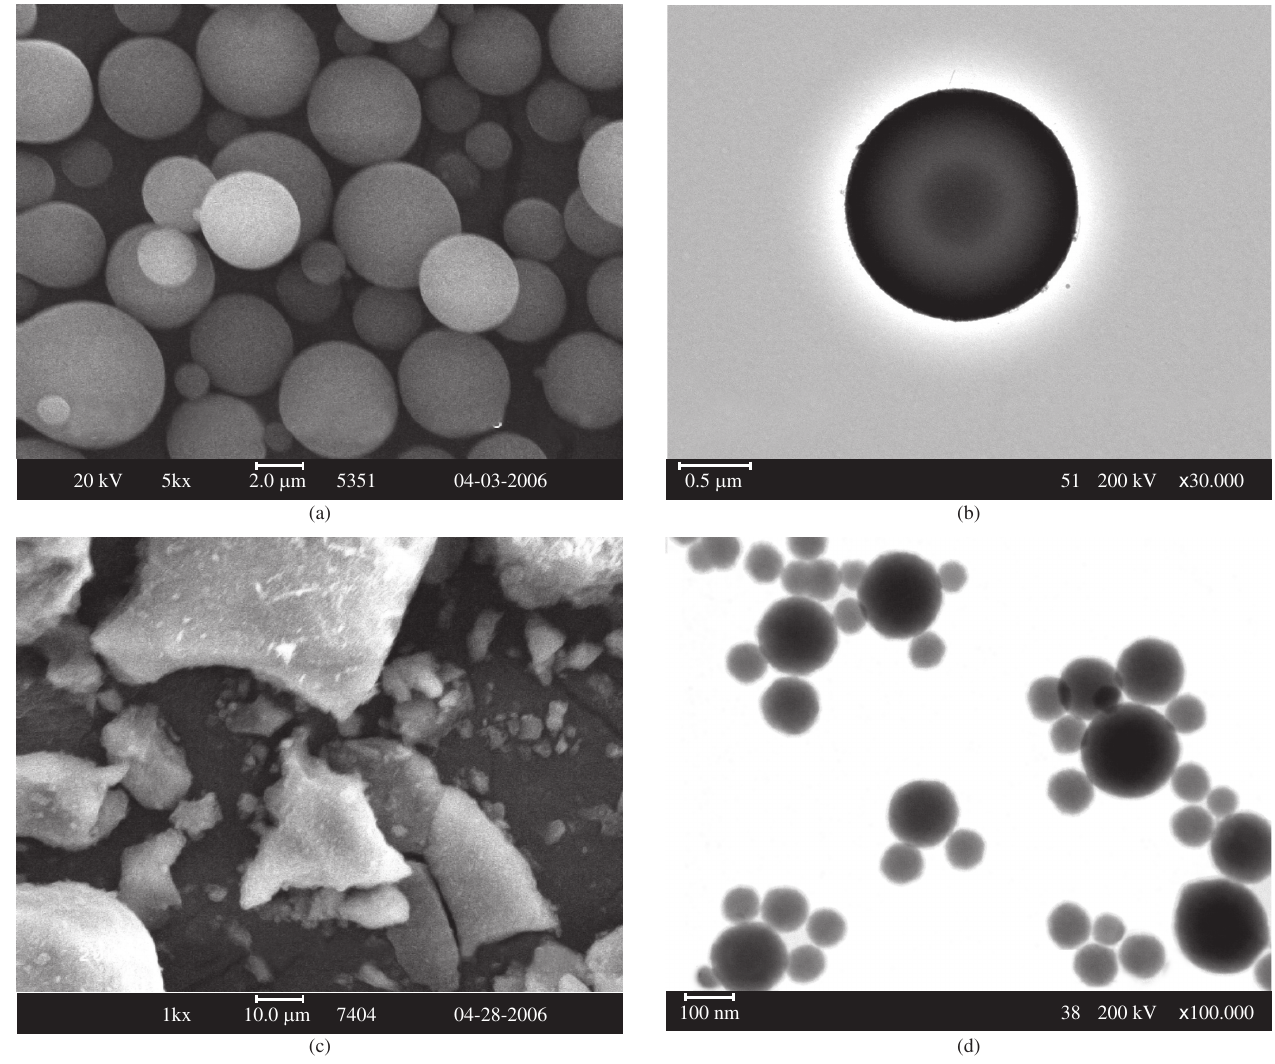
Figure 2. Scanning electron microscopic photograph of sample prepared from a) Tween 80 and Span 80 surfactant mixture and c) without surfactant and Transmission electron microscopic photograph of sample prepared from b) Tween 80 and Span 80 surfactant mixture and d) Tween 80/Span 80